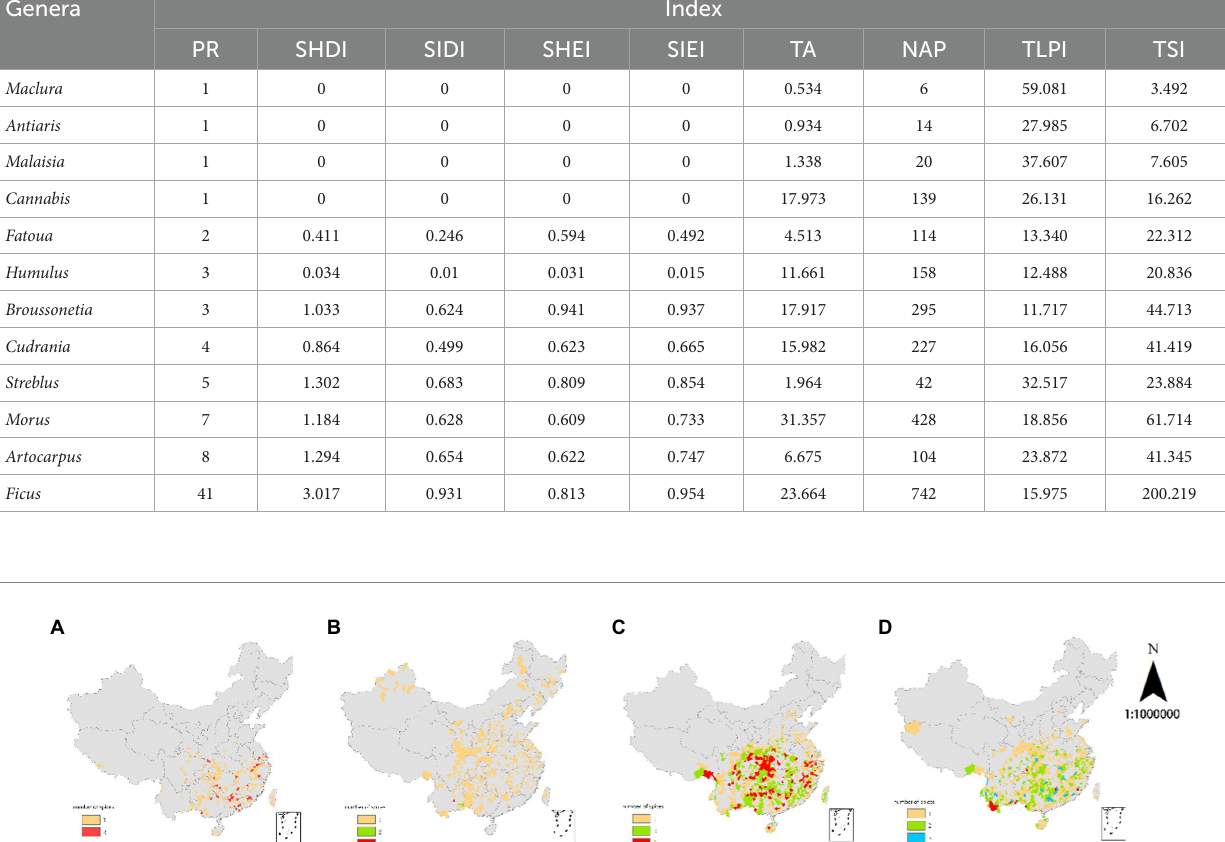
TABLE 2 Spatial diversity of genera in the Moraceae in China.